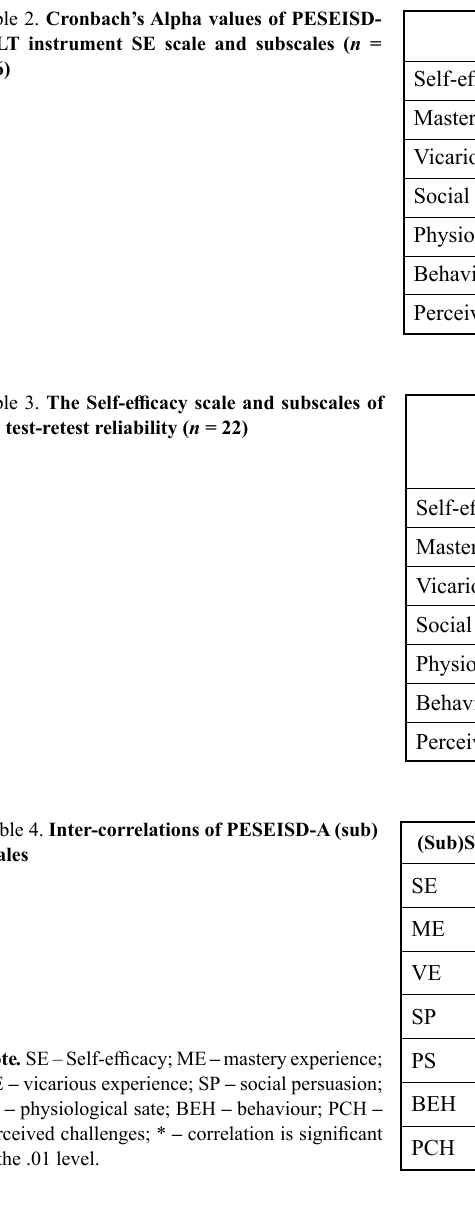
Table 2. Cronbach’s Alpha values of PESEISD- A-LT instrument SE scale and subscales ( n = 346)